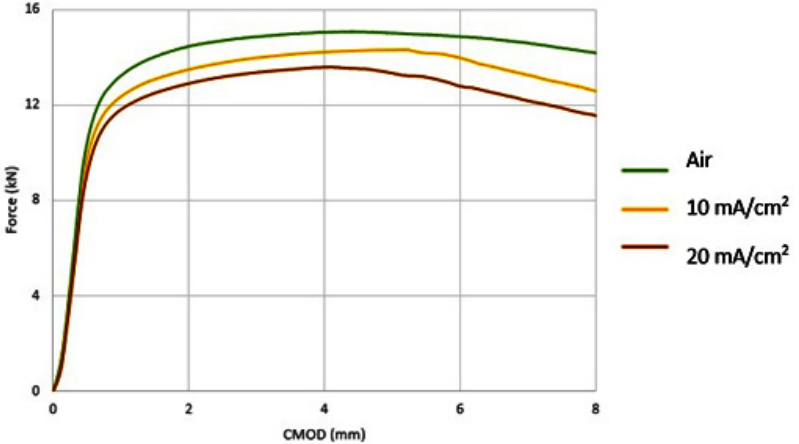
Figure 15. Force-Crack Mouth Open Displacement (CMOD) curves of CTOD tested X65 pipeline steel ( a ) in the uncharged condition; ( b ) after in situ hydrogen cathodic charging at 10 mA / cm 2 current density; ( c ) after in situ hydrogen cathodic charging at 20 mA / cm 2 current